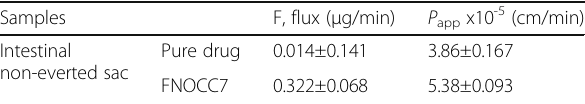
Table 6 Permeation flux and apparent permeability coefficient